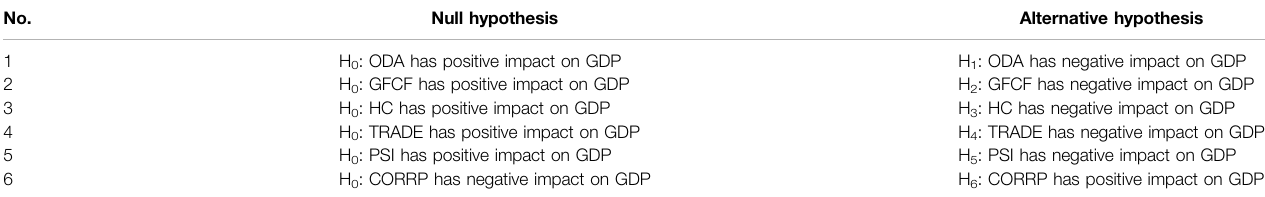
TABLE 1 | Hypothesis